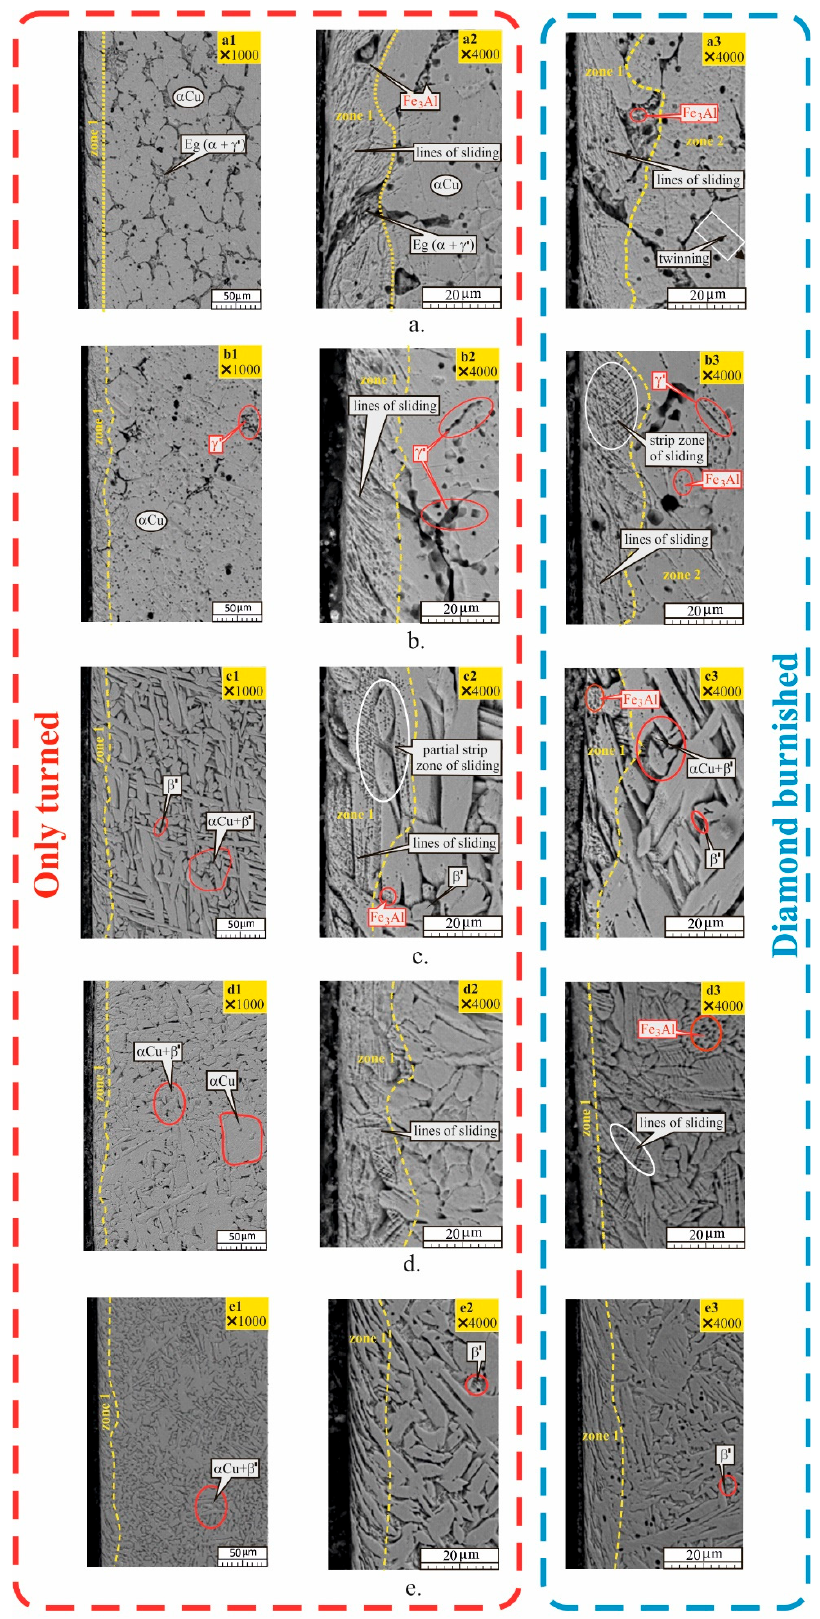
Figure 6. Microstructure of Cu-10Al-5Fe bronze: ( a ) as received; ( b ) annealed; ( c ) quenched; ( d ) quenched and tempered at 600 ◦ C; ( e ) quenched and tempered at 300 ◦ C.